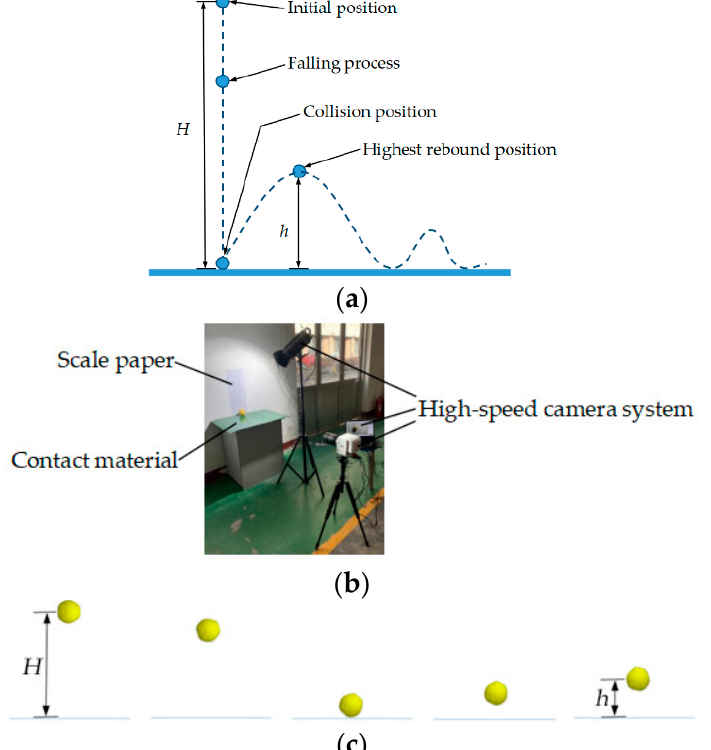
Figure 4. Calibration experiment of collision recovery coefficient between pears and materials. Experiment principle ( a ); Physical experiment ( b ); Simulation experiment ( c ).